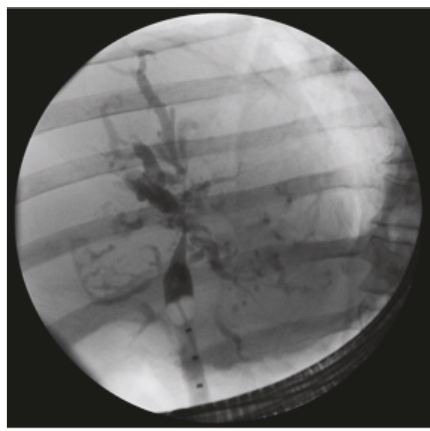
Figure 2: Endoscopic Retrograde Cholangiopancreaticogram showing sclerosing cholangitis.